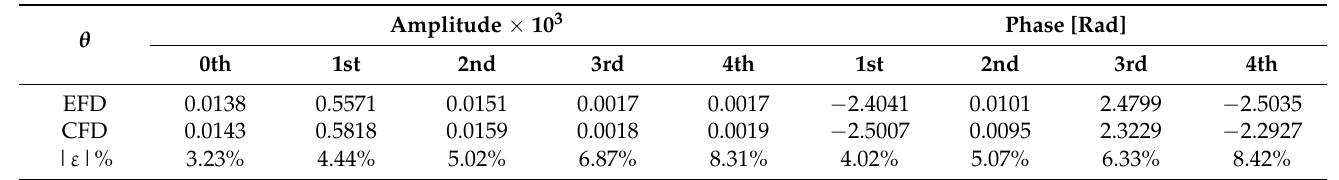
Table 13. Harmonic amplitudes and phases of pitch ( θ ) for the FRxz ϕθ bow waves